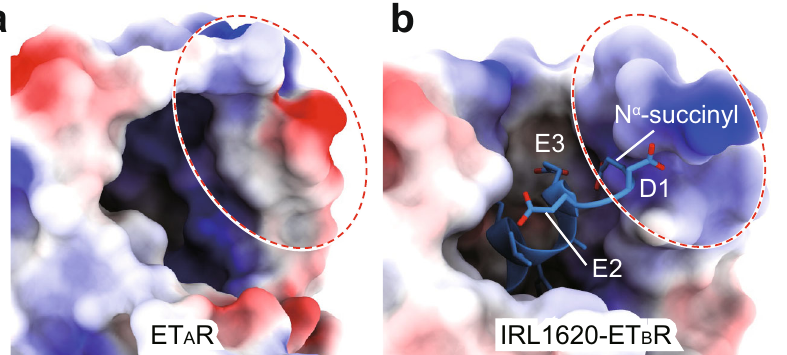
Fig. 4 | Electrostatic surfaces ofthe ET-1-bound ET A R and IRL1620-bound ET B R complex structures. The electrostatic surface presentation of the extracellular regions of ET-1 bound ET A R ( a ) and IRL1620-bound ET B R ( b ) are shown. ET-1 in the